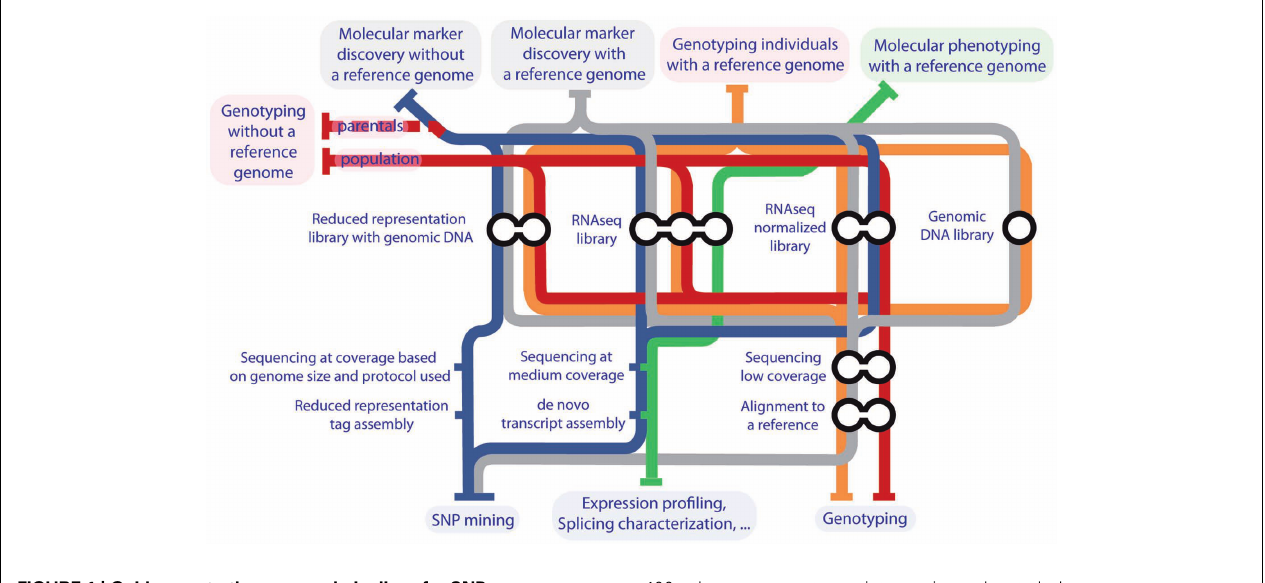
FIGURE 1 | Guide map to the proposed pipelines for SNP identification, genotyping, and molecular phenotyping for QTL analysis in plants. Medium coverage is considered from 20 × to